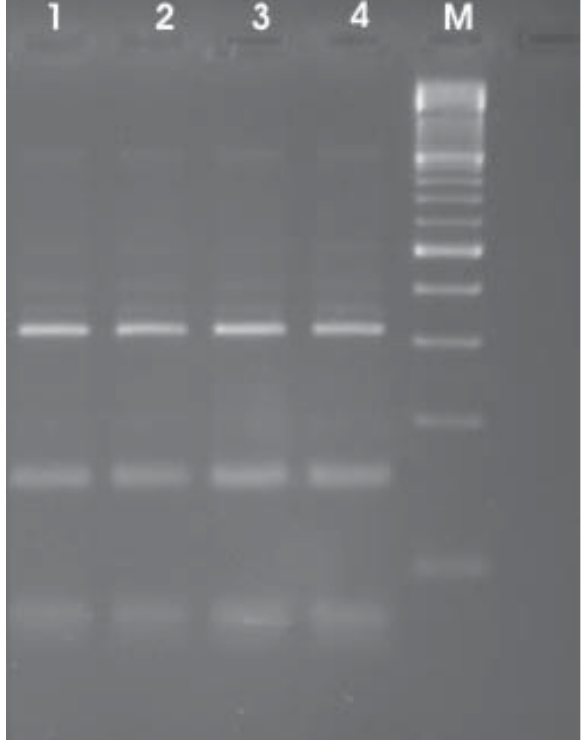
Fig. 2. Restriction analysis of the IGS region of the rDNA amplified by PCR, digested with Alu I and electro- phoresed in 3% agarose gel stained with ethidium bro- mide. Lanes 1–4: Armillaria mellea pattern mel 1 ob- tained from Vitis sp., Malus domestica , Camellia sp. and Olea europaea . The outside lane (M) on the left contains a 100 pb DNA molecular marker as a size standard.